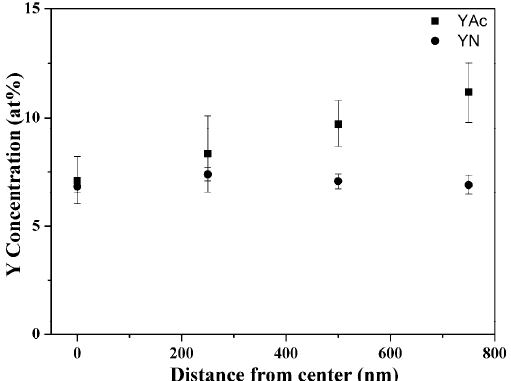
Figure 5. Mean Y concentration distributions of YAc- and YN-derived Y-doped BG powders.